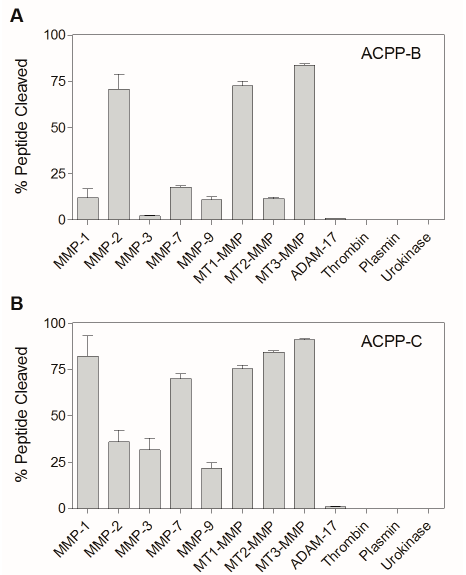
Figure 4. The percentage of released CPP from ( A ) ACPP-B and ( B ) ACPP-C (0.1